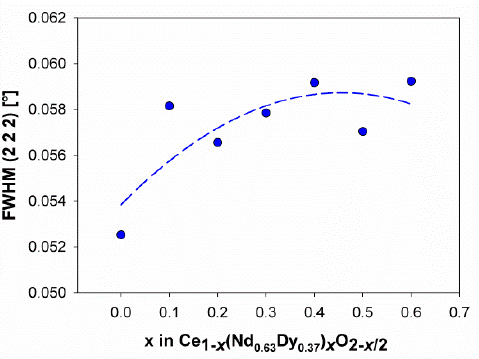
Figure 6. FWHM values of the most intense structure peak as a function of the Nd / Dy content. The dashed line is a second order polynomial function fitting experimental data.